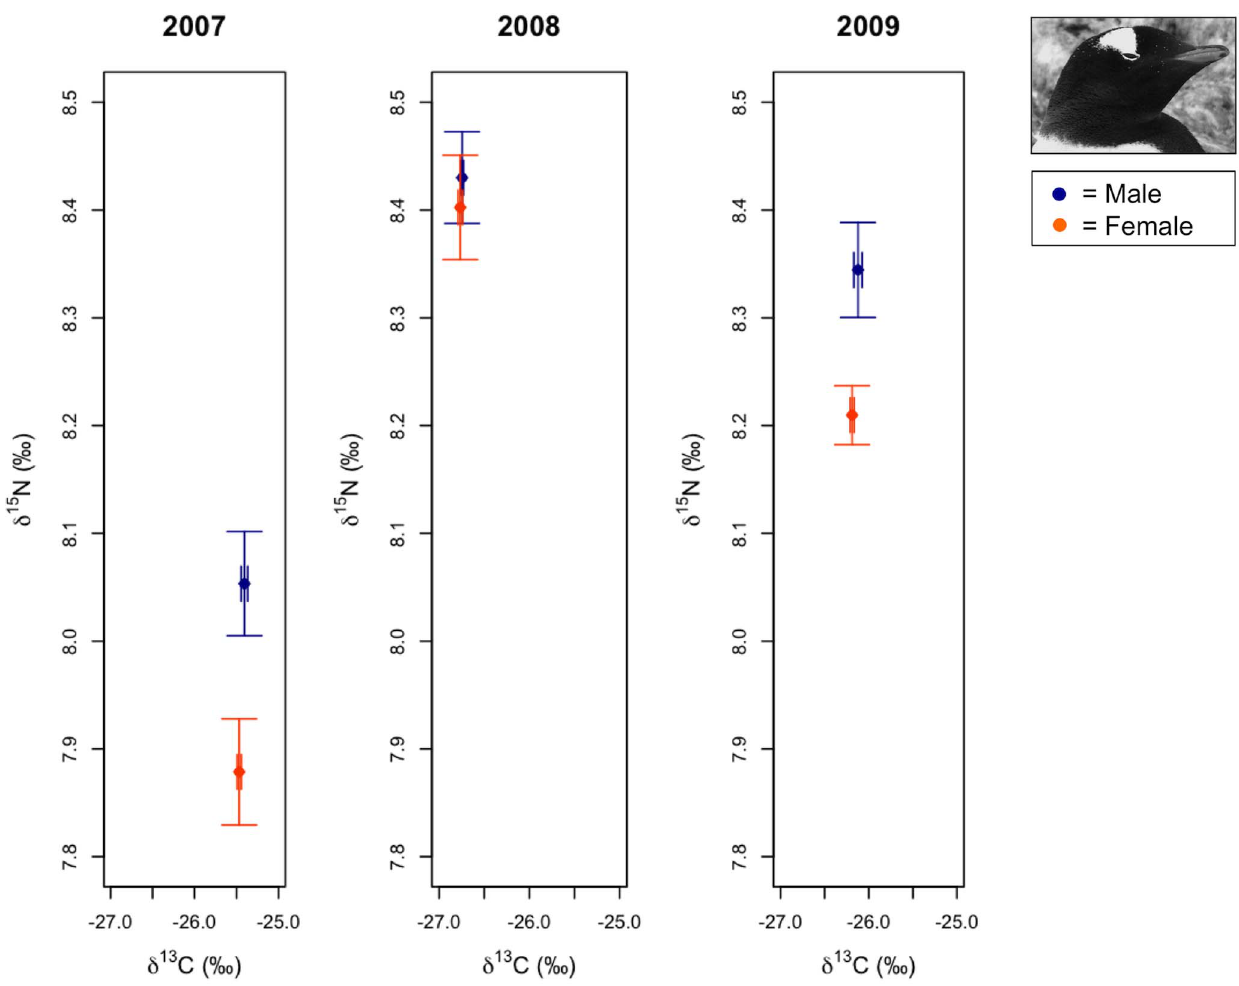
Figure S1 Examples of PCR bands from both P2/P8 and 2550F/2718R primers for three mated adult pairs of Pygoscelis penguins. (PDF) Table S1 Average nest initiation dates of Pygoscelis penguins relative to November 1 for each study year. (PDF) Text S1 PCR methods. (PDF)